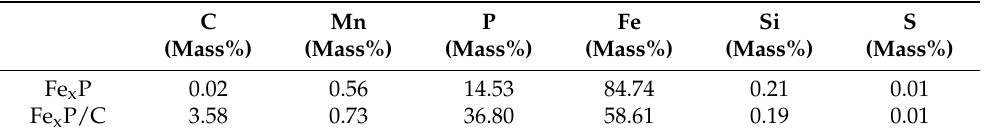
Table 1. ICP elemental analysis of Fe x P and Fe x